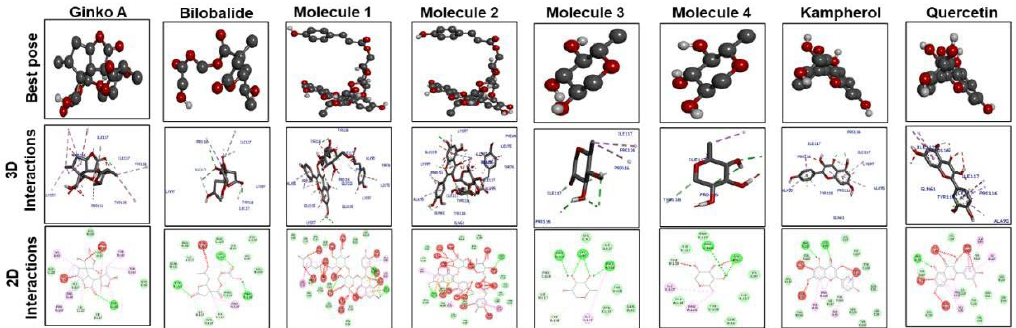
Figure 8. The di ff erent panels represent the docking analysis and best pose of ginkgolide A, bilobalide, Figure 8. The different panels represent the docking analysis and best pose of ginkgolide A, 3-O-(2 (cid:48) -O-(6 (cid:48) -O-(p-coumaroyl)- β - d -glucosyl)- α - l -rhamnosyl)kaempferol(Molecule1), 3-O-(2 (cid:48) -O-(6 (cid:48) -O- bilobalide, 3-O-(2′-O-(6′-O-(p-coumaroyl)-β- D -glucosyl)-α- L -rhamnosyl) kaempferol (Molecule 1), 3- (p-coumaroyl)- β - d -glucosyl)- α - l -rhamnosyl) quercetin (Molecule 2), 3-O-(2 (cid:48) -O,6 (cid:48) -O-bis( α - l -rhamnosyl) O-(2′-O-(6′-O-(p-coumaroyl)-β- D -glucosyl)-α- L -rhamnosyl) quercetin (Molecule 2), 3-O-(2′-O,6′-O- - β - d -glucosyl)kaempferol (Molecule 3), 3-O-(2 (cid:48) -O,6 (cid:48) -O-bis( α -L-rhamnosyl)- β - d -glucosyl) quercetin bis(α- L -rhamnosyl)-β- D -glucosyl)kaempferol (Molecule 3), 3-O-(2′-O,6′-O-bis(α-L-rhamnosyl)-β- D - (Molecule 4), quercetin, and kaempferol after docking with TNF- α . Both 2D and 3D shapes of the glucosyl) quercetin (Molecule 4), quercetin, and kaempferol after docking with TNF-α. Both 2D and drug-receptor complex were visualized by DSV. 3D shapes of the drug-receptor complex were visualized by DSV.